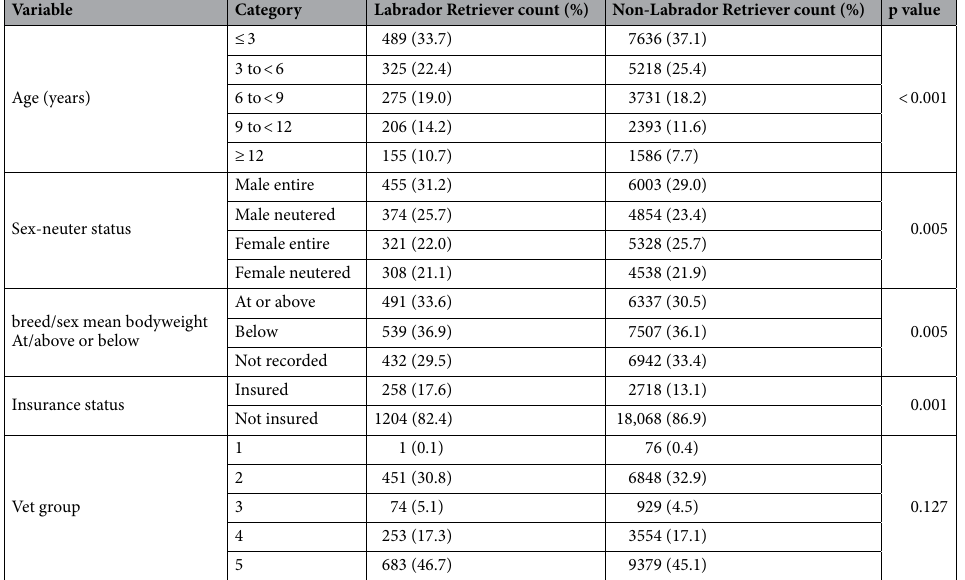
rador Retrievers and the 30 most common specific-level disorders in non-Labrador Retrievers resulted in a combined list of 35 specific-level disorders. The majority of these disorders overlapped, other than kennel cough, moist dermatitis, laceration, stiffness, coughing and papilloma which were exclusive to the 30 most common specific-level disorders in Labrador Retrievers. Conversely, heart murmur, flea infestation, atopic dermatitis, skin cyst, patellar luxation and retained deciduous tooth were exclusive to the 30 most common specific-level disorders in non-Labrador Retrievers. After accounting for confounding using multivariable methods, Labrador Retrievers had significantly increased odds of 12/35 (34.3%) disorders compared to non-Labrador Retrievers. Disorders in Labrador Retriev- ers with the highest odds (i.e. predisposition) were: osteoarthritis (OR 2.83; 95% CI 2.21–3.62; p < 0.001), lipoma (OR 2.45; 95% CI 1.79–3.34; p < 0.001), kennel cough (OR 2.27; 95% CI 1.54–3.36; p < 0.001), laceration (OR 2.16; 95% CI 1.36–3.45; p = 0.001) and stiffness (OR 2.08; 95% CI 1.30–3.35; p = 0.002). Conversely, Labrador Retrievers had reduced odds (i.e. protection) for 7/35 (20.0%) specific-level disorders compared to non-Labrador Retriev- ers. The specific-level disorders with greatest protection were: patellar luxation (OR 0.18; 95% CI 0.06–0.55; p = 0.003), heart murmur (OR 0.20; 95% CI 0.10–0.40 (p < 0.001), flea infestation (OR 0.22; 95% CI 0.11–0.47; p < 0.001), retained deciduous tooth (OR 0.28; 95% CI 0.10–0.75; p = 0.011) and periodontal disease (OR 0.43; 95% CI 0.35–0.54; p < 0.001) (Fig. 1). Grouped-level predispositions and protections. The 30 most common grouped-level disorders in Labrador Retrievers and the 30 most common grouped-level disorders in non-Labrador Retrievers resulted in a combined list of 32 grouped-level disorders. The majority of these disorders overlapped, other than collapsed and oral cavity disorder which were exclusive to the 30 most common grouped-level disorders in Labrador Retrievers. Conversely, hernia and disorder not diagnosed were exclusive to the 30 most common grouped-level disorders in non-Labrador Retrievers. After accounting for confounding using multivariable methods, Labrador Retrievers had significantly increased odds of 8/32 (25%) disorders compared to non-Labrador Retrievers. The highest disorder predisposi- tions were: oral cavity disorder (excluding dental) (OR 2.06; 95% CI 1.12–3.82; p = 0.021), neoplasia (OR 1.89;